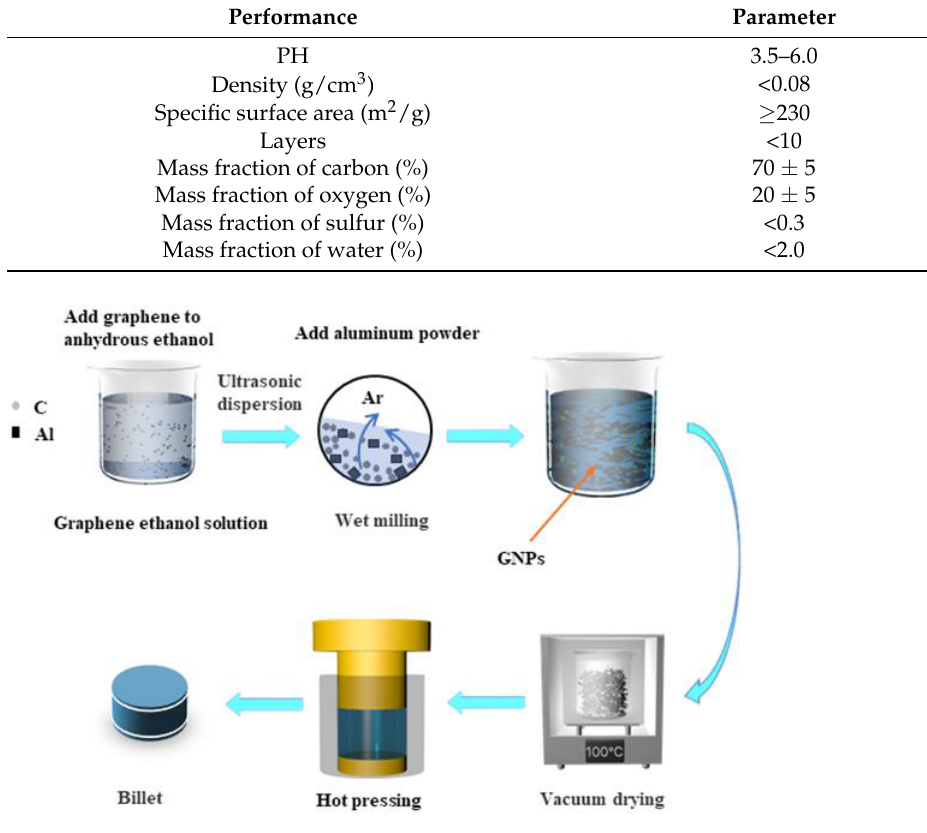
Figure 1. ( a ) SEM image of pure aluminum; ( b ) particle size distribution of pure aluminum; ( c ) TEM image of GNPs; ( d ) high-magnification TEM image of GNPs. Table 2. Performance of the GNP.